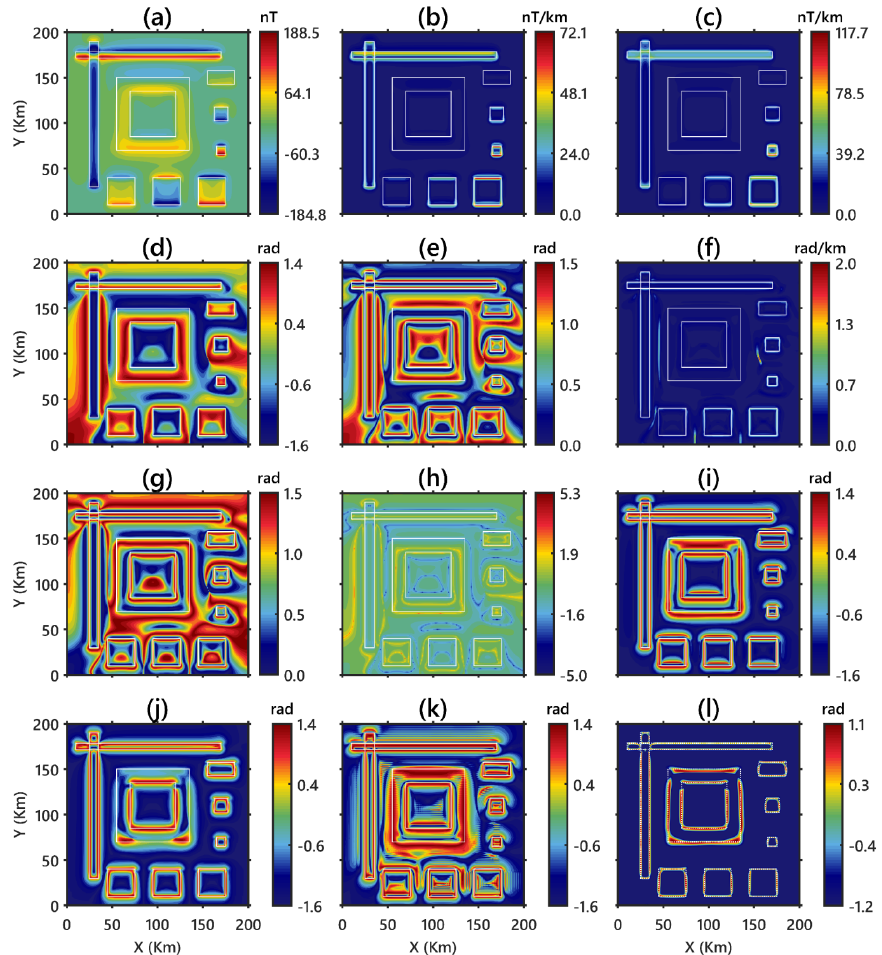
Figure 5. The second case. ( a ) The magnetic anomaly; ( b ) HG; ( c ) AS; ( d ) TA; ( e ) TM; ( f ) HGTA; ( g ) TDX; ( h ) HTA; ( i ) TAHG; ( j ) TAAS; ( k ) TBHG; and ( l ) ETG. The white lines show the true edge of the prisms.